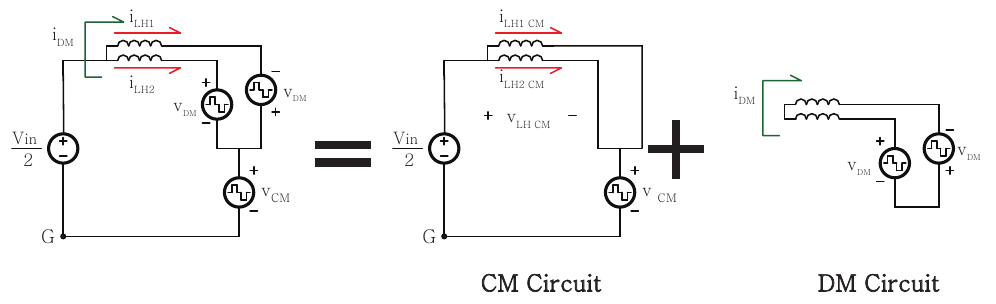
Figure 5. Equivalent circuit for the analysis of circulating